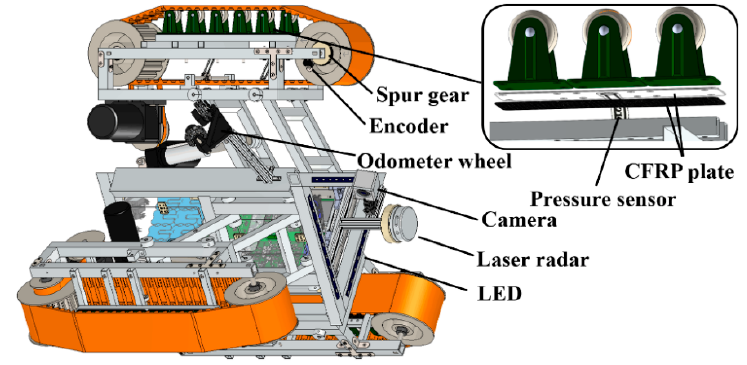
Figure 3. Sensors on the in-pipe robot.